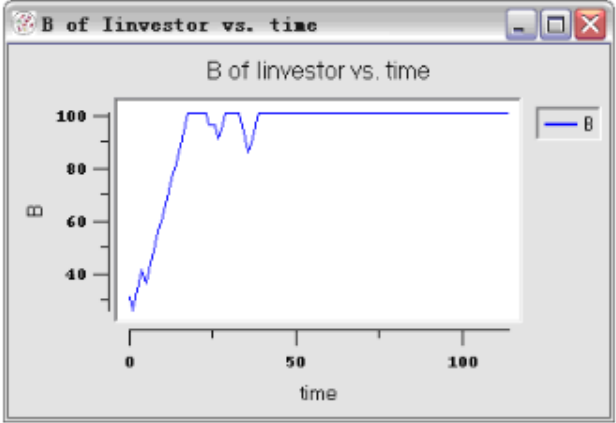
Figure 5. The change of encroachment ratio B without regulation